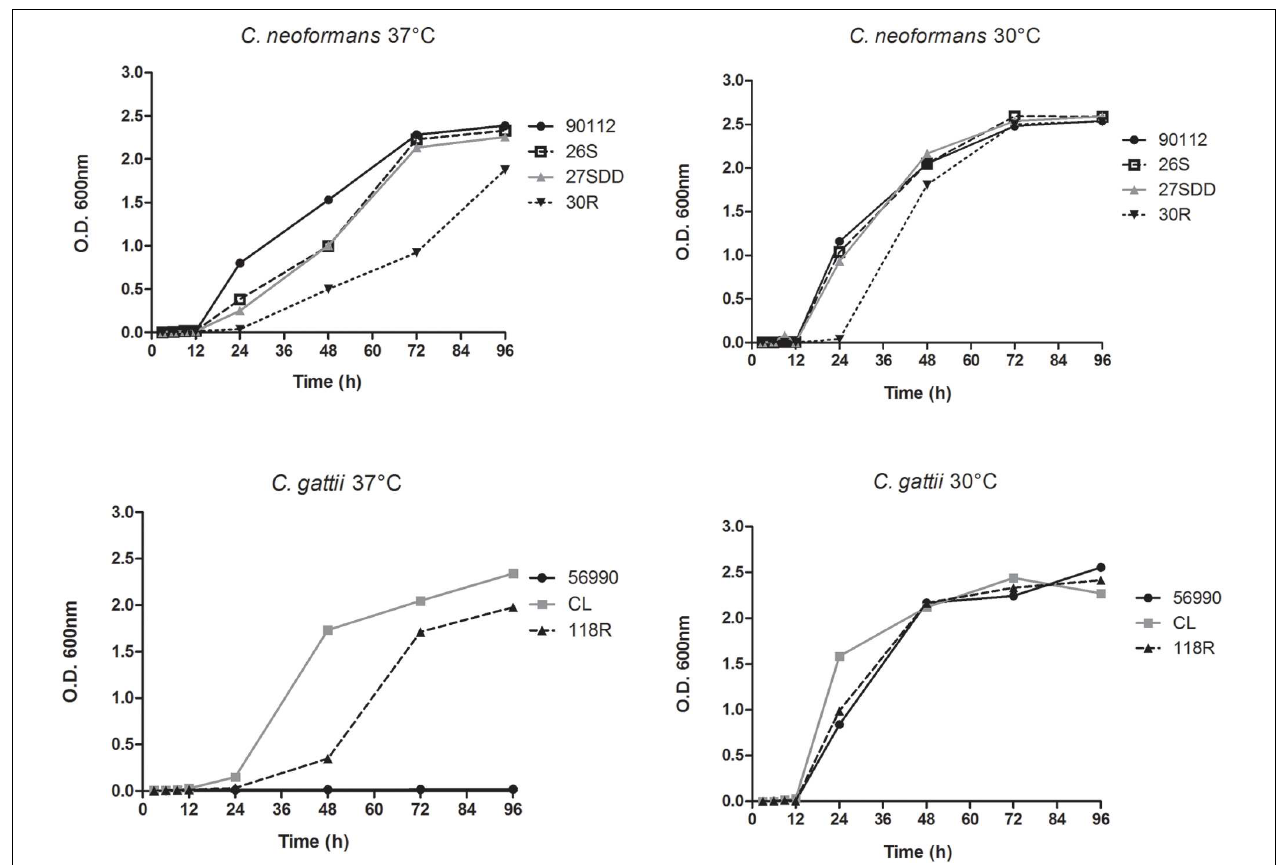
FIGURE 1 | Sequential growth curve of Cryptococcus neoformans isolates, C. gattii isolates and the ATCC strains 90112 and 56990 at 30 and 37 ◦ C.